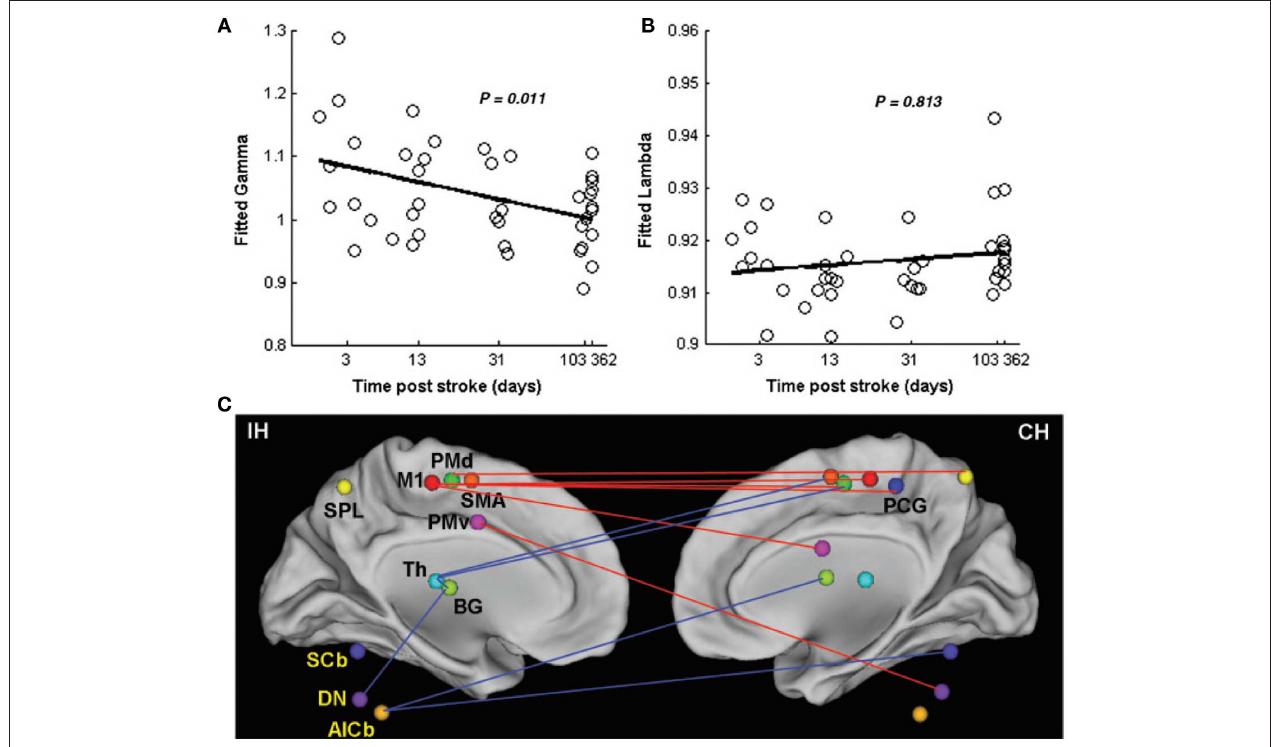
regions. Reduced connectivity (blue lines) is mainly found in ipsilesional subcortical areas and cerebellum. IH, ipsilesional hemisphere; CH, contralesional hemisphere; M1, primary motor cortex; PCG, post-central gyrus; PMd, dorsolateral premotor cortex; PMv, ventrolateral premotor cortex; SMA, supplementary motor area; Th, thalamus; BG, basal ganglia; SPL, superior parietal lobule; SCb, superior cerebellum; DN, dentate nucleus; AICb, anterior inferior cerebellum. Reprinted with permission (Wang et al.,